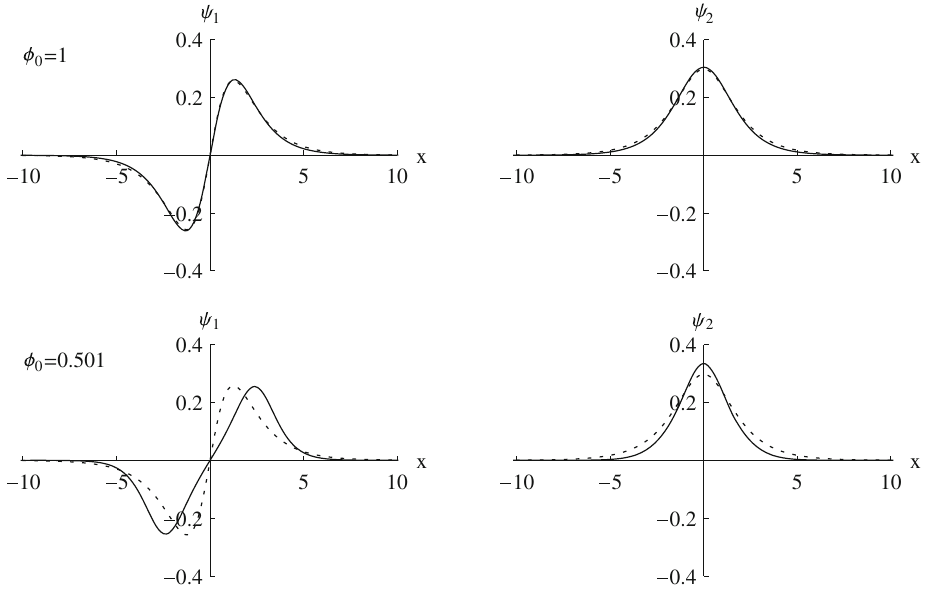
Fig. 4 The positive energy fermionic bound state as a function of x for φ 0 = 1 and φ 0 = 0 . 501. Solid and dashed curves show the fermionic bound state in the dynamical and background models, respectively